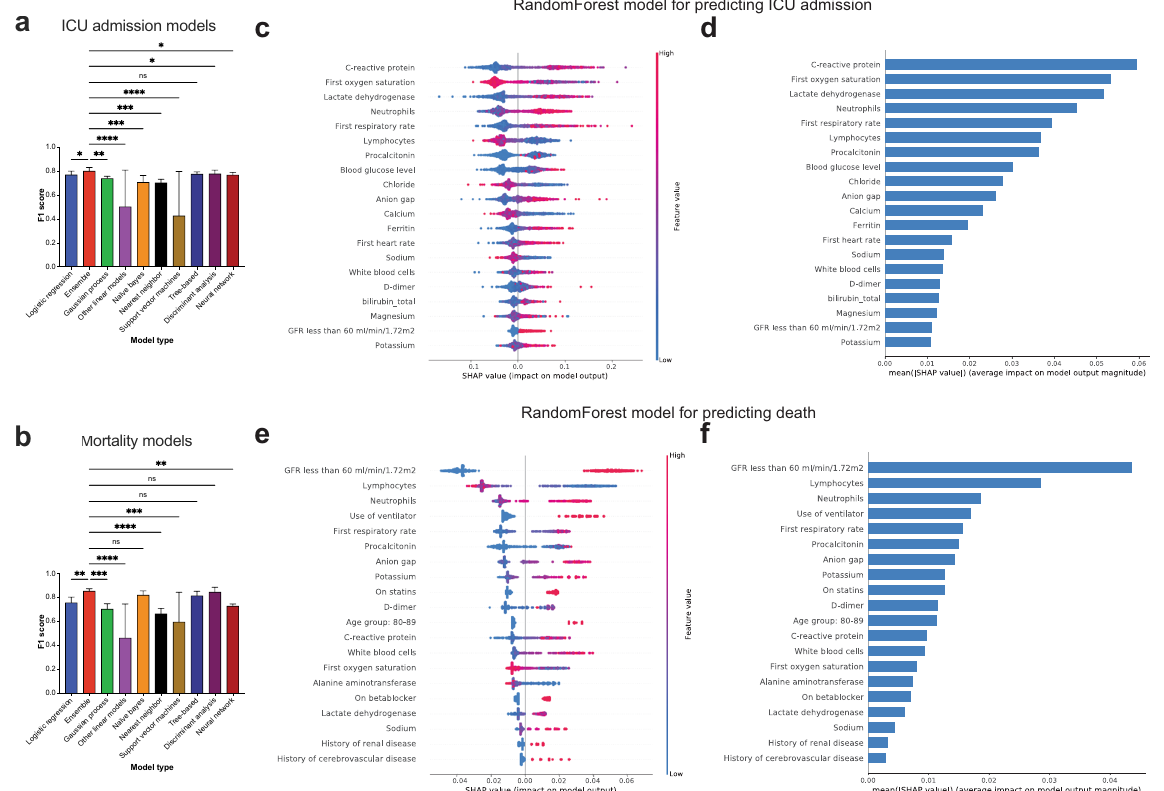
Fig. 2 F1 score comparison and variables of importance for ICU admission and mortality prediction models. a, b Bar plots representing the F1 scores of ICU admission and mortality prediction models. Error bars indicate standard deviation from mean. Statistical analysis was performed using Two-stage step-up method of Benjamini, Krieger and Yekutieli test which controls for False discovery rate (FDR) during multiple comparison. p- value style is geometric progression - <0.03 (*), <0.002 (**), <0.0002 (***), <0.0001 (****). c SHAP value summary dot plot and d variable importance of RandomForest algorithm-based ICU admission model. e SHAP value summary dot plot and f variable importance of RandomForest algorithm-based mortality model. The calculation of SHAP values is done by comparing the prediction of the model with and without the feature in every possible way of adding the feature to the model. The bar plot depicts the mean SHAP values whereas the summary dot plot shows the impact on the model. The color of the dot represents the value of the feature and the X-axis depicts the direction and magnitude of the impact. Red colored dots represent high value of the feature and the blue represents lower value. A positive SHAP value means the feature value increases likelihood of ICU admission/mortality. For features with positive SHAP value for red dots, suggests directly proportional variable to outcome of interest and those with positive SHAP value for blue dots, suggest inverse